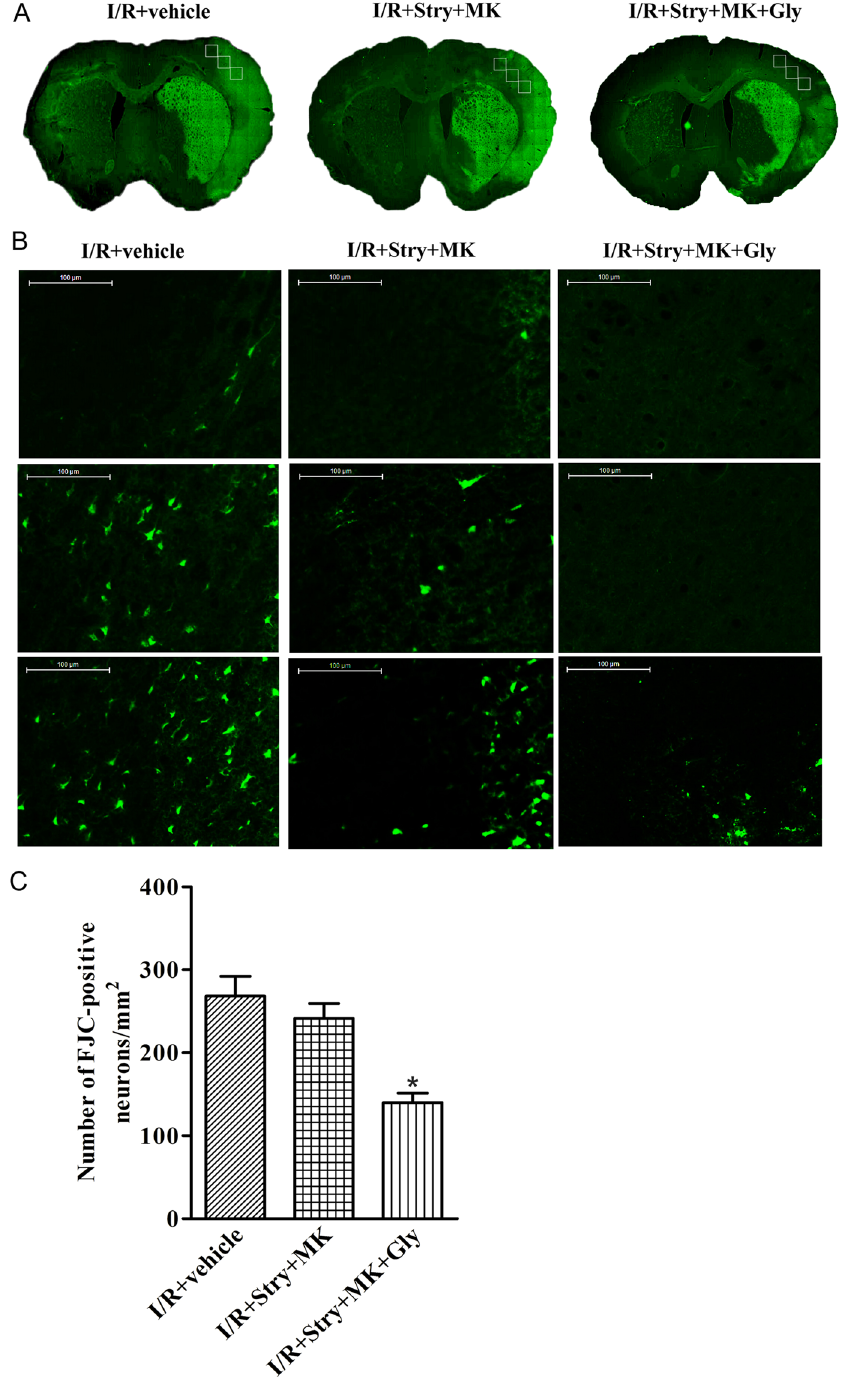
Figure 2. Glycine treatment reduces cell loss in the ischemic brain where NMDAR channel activity and glycine receptors are inhibited. ( A ) Sample images of FJC strained-brain sections collected at 3 d after ischemia onset. Glycine (100 µ g/100 g, icv) was administered at 3 h following I/R. At 30 min prior to glycine injection, MK-801 (8.0 µ g/100 g, icv) and strychnine (1.2 µ g/100 g, icv) were injected. ( B ) The bottom panel is a higher magnification of three regions in the upper panel marked with a frame. Bar = 100 μ m. ( C ) Quantitative analysis of FJC-positive degenerating neurons in the ischemic brain area at 3 d after ischemia onset (n = 6, ANOVA test, * P < 0.05 vs. I/R + Stry + MK). Stry: Strychnine; Gly: glycine; MK: